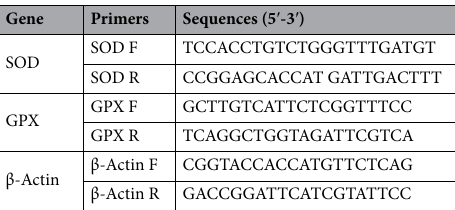
Table 8. Sequences of the qPCR primers used in the